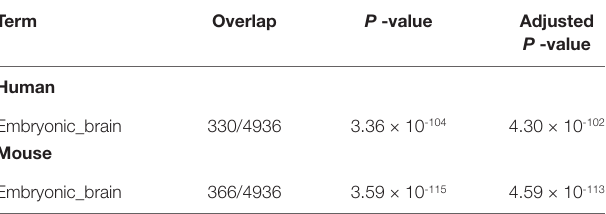
TABLE 5 | Enrichment of embryonic brain by “JENSEN TISSUES” in Enrichr.